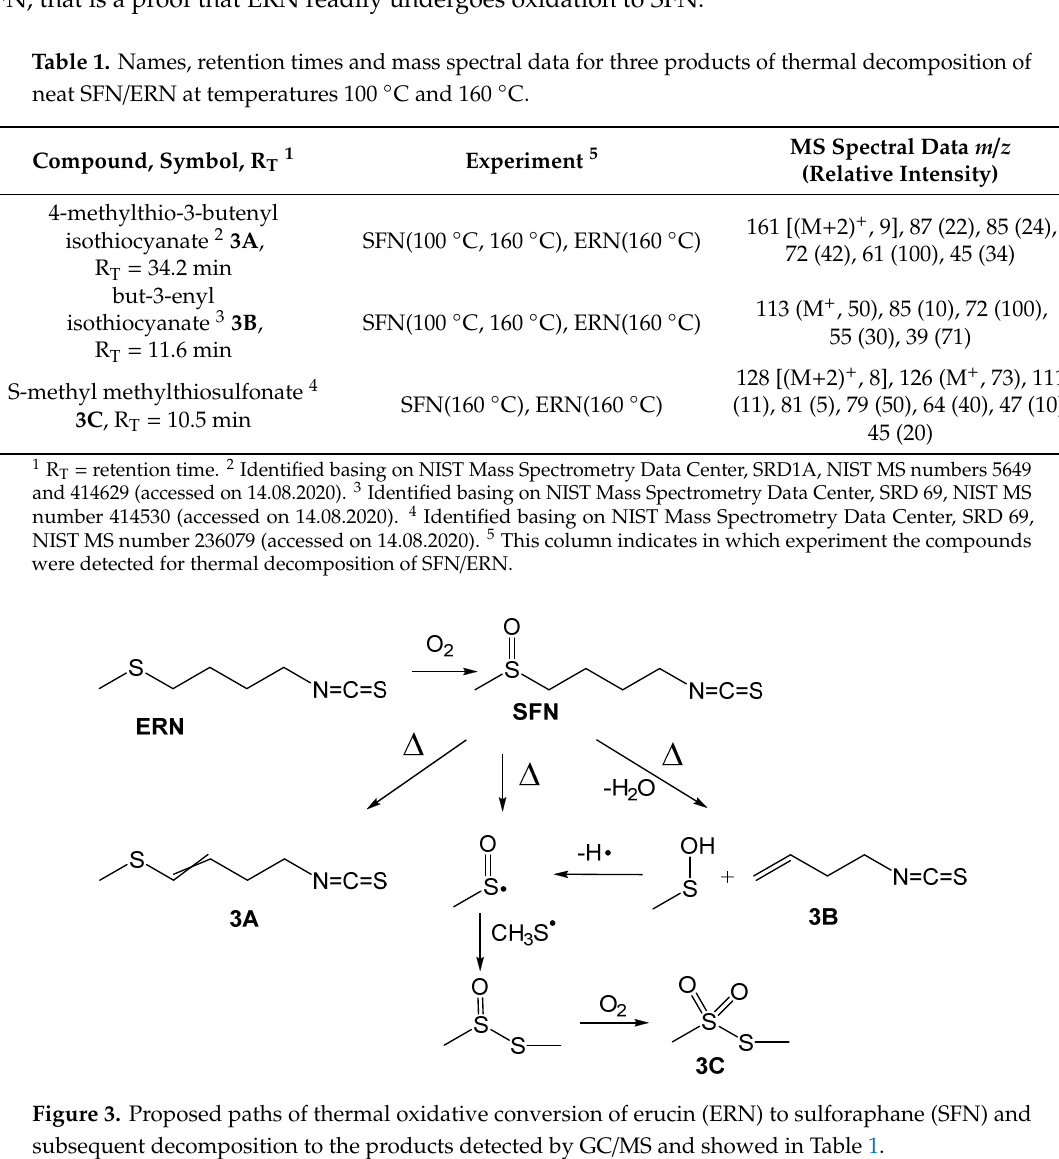
Table 1. Names, retention times and mass spectral data for three products of thermal decomposition of neat SFN / ERN at temperatures 100 ° C and 160 ° C.